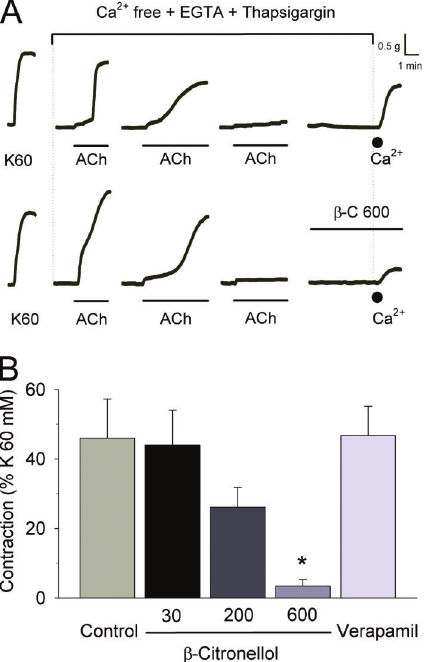
Figure 4. Inhibitory effects of b -citronellol on smooth-muscle contraction induced by store-operated capacitative Ca 2 + entry. Panel A , typical traces of experiments conducted in tracheal pre- parations maintained in the presence of thapsigargin (1 m M) to produce activation of capacitative Ca 2 + entry in response to repeated stimulation of tracheal rings with acetylcholine (60 m M ACh) in Ca 2 + -free medium (containing 4 mM EGTA). Emptying of intracellular Ca 2 + stores was considered complete if a given stimulus applied with ACh did not produce a contraction. At this moment, ACh was removed from the extracellular medium by consecutive washings (4 – 5 times) with Ca 2 + -free solution. After- wards, 2.5 mM Ca 2 + (black circle) was added to the organ-bath solution, a procedure that elicited a contraction in control prepara- tions (upper traces). In the presence of b -citronellol (30 – 600 m M; panel B ), the contraction induced by Ca 2 + restoration to the extracellular medium was decreased gradually and achieved a signi fi cant reduction at 600 m M b -citronellol (lower traces). Panel B is a graph with the means ± SE values for these fi ndings. Verapamil (1 m M) did not change the contraction induced by Ca 2 + restoration. % P o 0.05 compared to control contraction in the absence of b -citronellol (Dunn ’ s